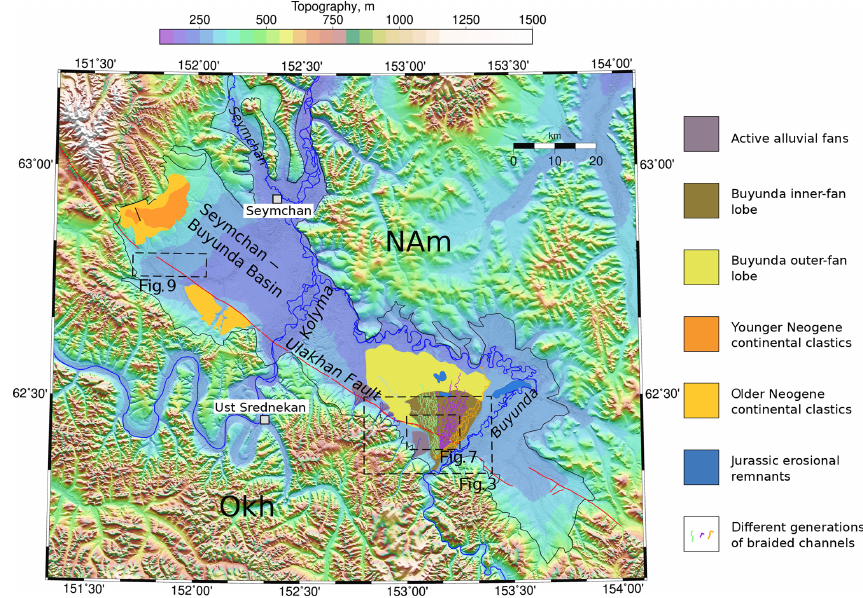
Figure 2. Morphology and drainage of the Seymchan–Buyunda basin, showing Buyunda fan structure, palaeodrainage networks on fan surface, subsidiary fans along southern basin edge, Neogene sedimentary outcrops and the trace of the fault segment across the Seymchan Basin, identified from aerial photographs, satellite imagery and the TANDEM-X 0.4arcsec